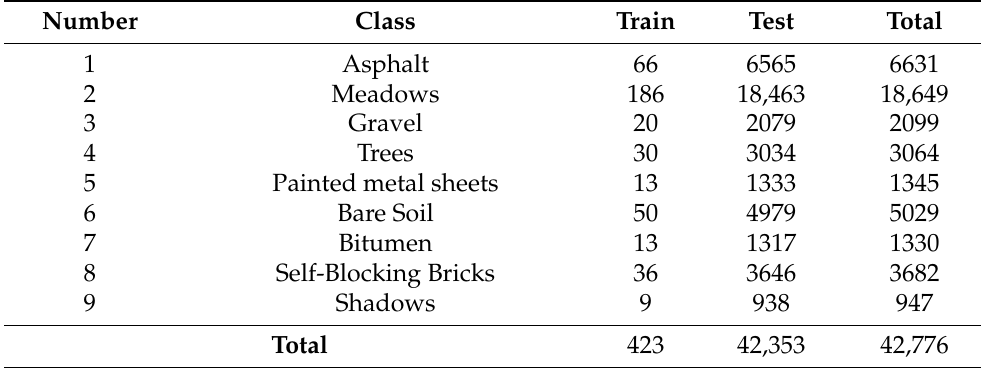
Table 7. The samples for each category of training and testing for the Pavia University